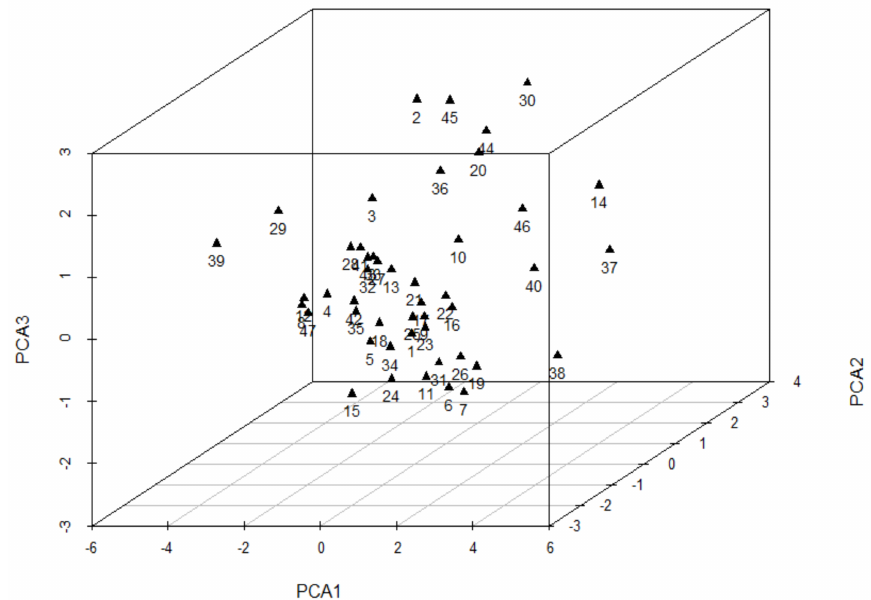
Figure 5. Principal component analysis diagram of 47 woody species based on ecophysiological traits. Species numbers are shown in Table